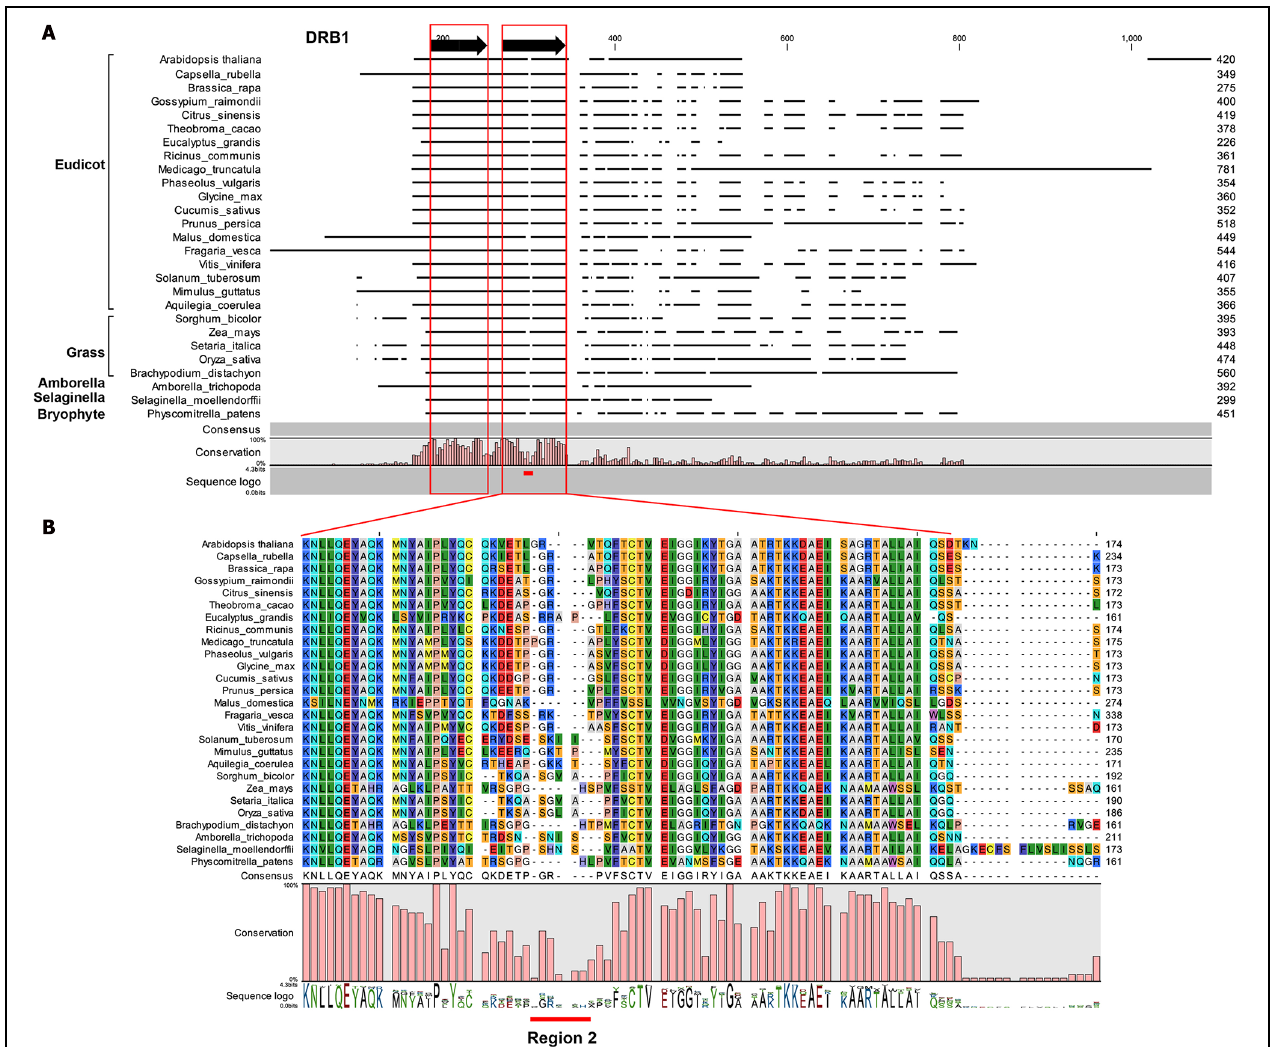
FIGURE 4 | Evolutionary conservation of DRB1. (A) An overview amino acid sequence alignment of Arabidopsis DRB1 (used as the search query) and orthologs identified in other plant species. The regions corresponding to the two dsRBDs of each analyzed DRB1 are indicated by the red boxes. Region 2, which has low sequence conservation in dsRBD1 of DRB1, is indicated by the solid red line. (B) Alignment of the amino acid sequence of the dsRBD2 domains of each plant DRB1. The solid red line identifies region 2, the region of low sequence conservation in dsRBD2 of